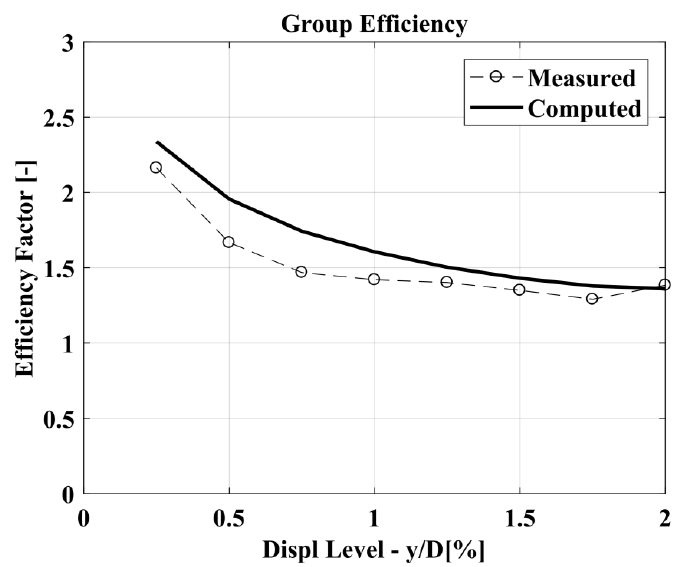
Figure 14. Computed vs. measured load-deflection curves.